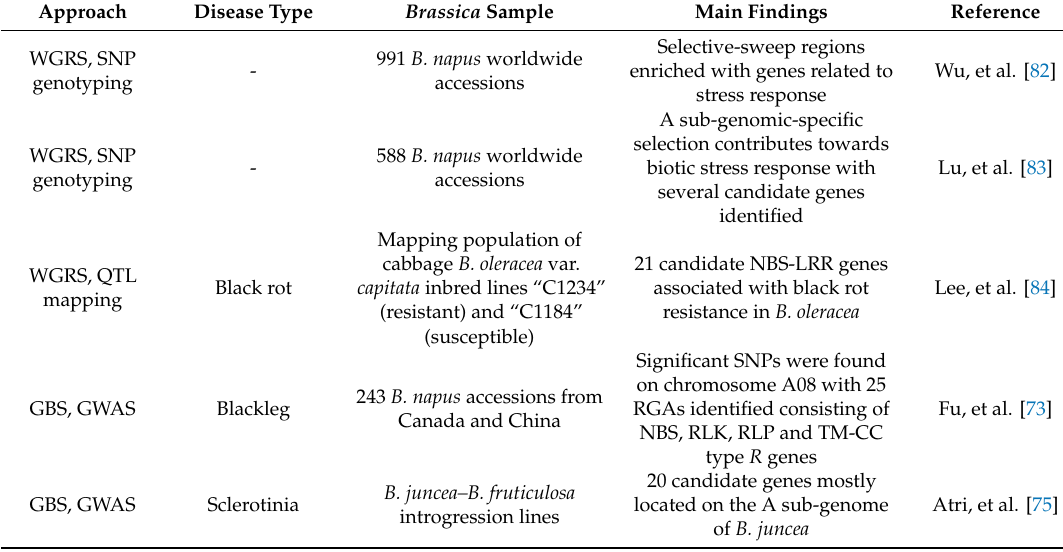
Table 2. Summary of application of next-generation sequencing (NGS)-based SNP genotyping approaches in resistance studies of Brassica